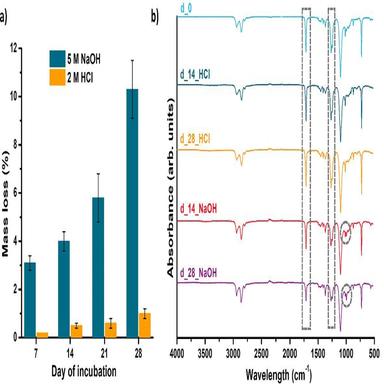
Results of accelerated degradation study performed in 5 M NaOH and 2 M HCl solutions of porous matrix printed using Bioflex® filament, (a) percentage mass loss during degradation, (b) FTIR spectrum collected at a different time of degradation.